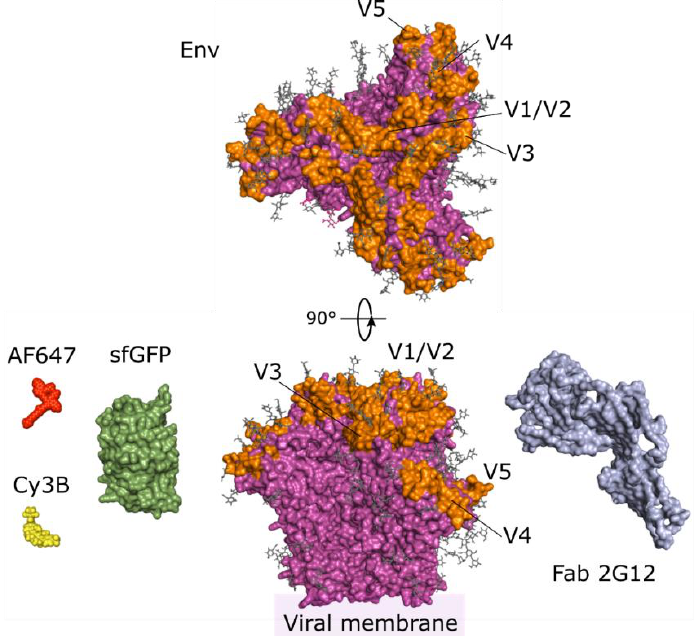
Figure 2. Structure of Env and previously employed labels. Env (magenta, PDB 5FUU [78]) is usually labelled in variable loops (V1-5, orange). Note that due to their disordered nature, a number of variable loop residues remain unresolved and are not depicted. Env glycans (grey sticks) can also be labelled by click chemistry [77]. Different labelling strategies have been employed to label Env, such as insertion of the fluorescent protein sfGFP (green, PDB 2B3P [79]) into variable loops, immunostaining by the 2G12 Fab (blue, PDB 6E5P [80]), or enzymatic incorporation of the organic dyes Cy3B (yellow) and Alexa Fluor 647-NHS ester (AF647, red). Note that up to three label units can be incorporated per Env protein.